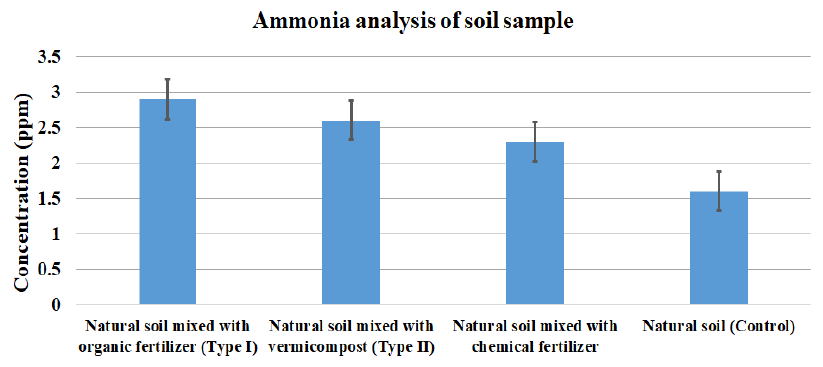
Figure 6. Ammonia analysis for prepared liquid sample of fertilized